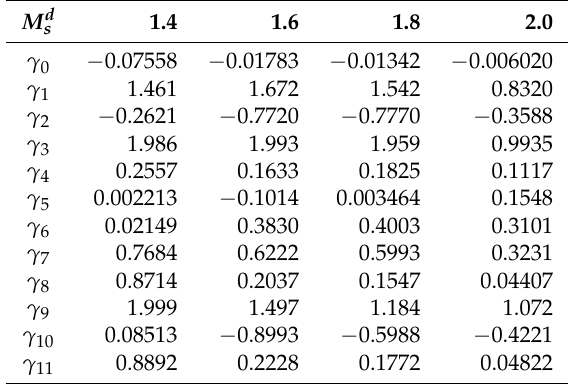
Table 3. Coefficient parameters γ i ( M d s ) for τ d in the servo mode.